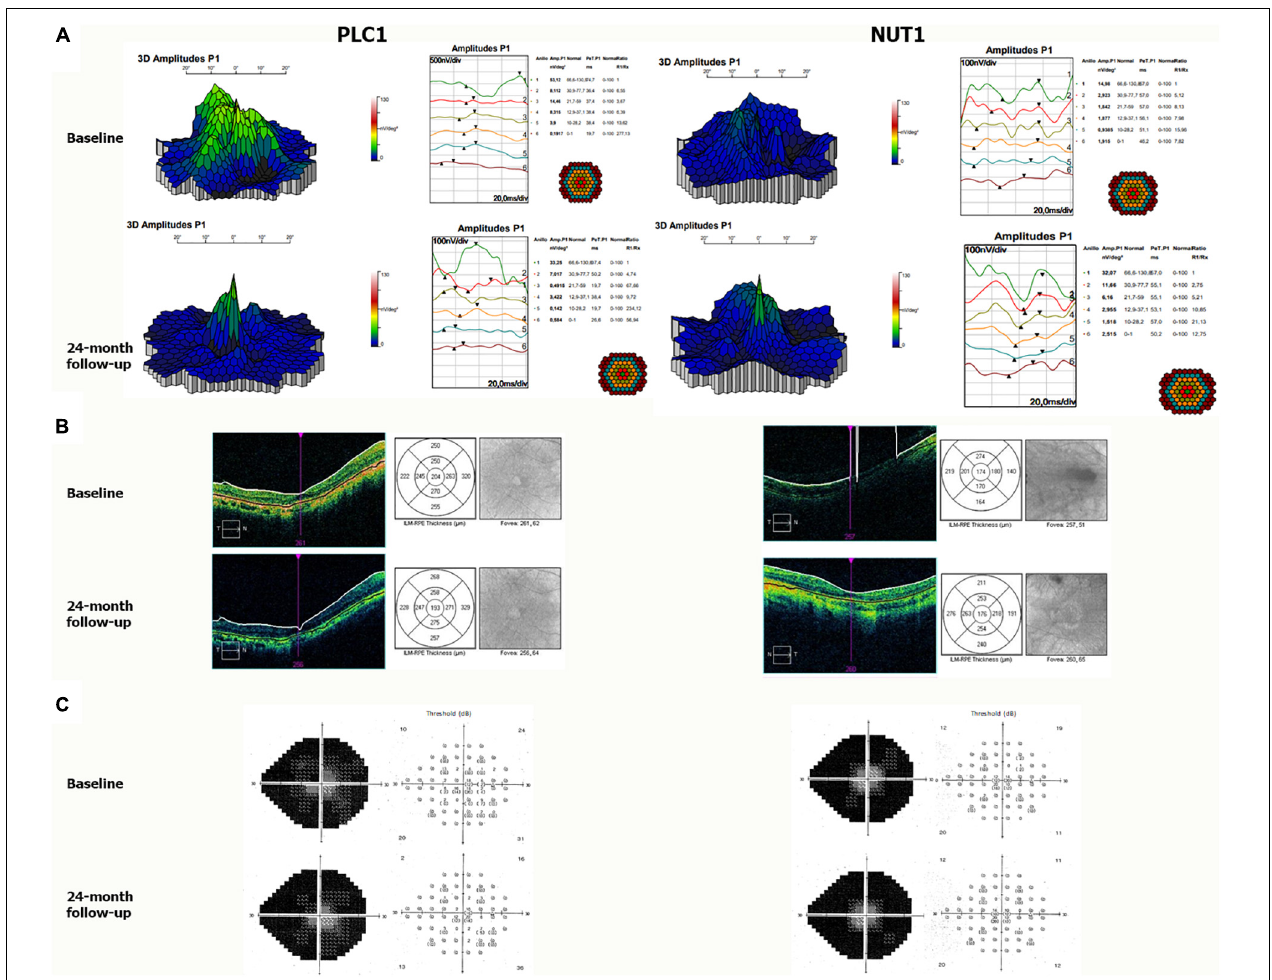
FIGURE 5 | Representative visual outcomes of two patients who received NUT or placebo. (A) mfERG tests showing 3D map of P1 amplitudes (right) and ring analysis of P1 amplitudes (left); (B) Cirrus SD-OCT analysis showing retinal images and corresponding segmentation map, nine Early Treatment Diabetic Retinopathy Study (ETDRS) regions; and (C) automated VF showing grayscale map (right) and threshold (left) of retinal sensitivity in decibel (dB) from the right eye before and after 2 years of supplementation with PLC or NUT. PLC1, patient one with RP who received placebo; NUT1, patient one with RP who received